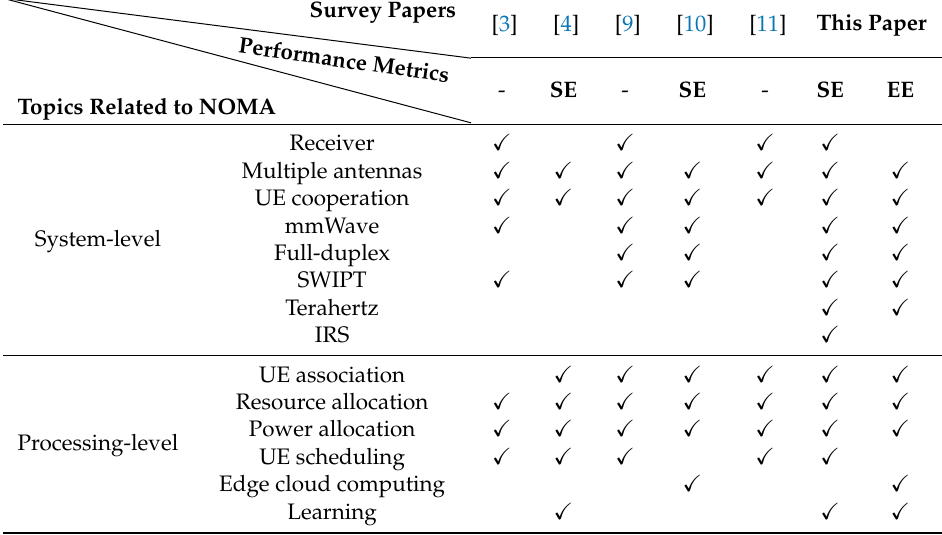
Table 1. Comparison of survey papers on non-orthogonal multiple access